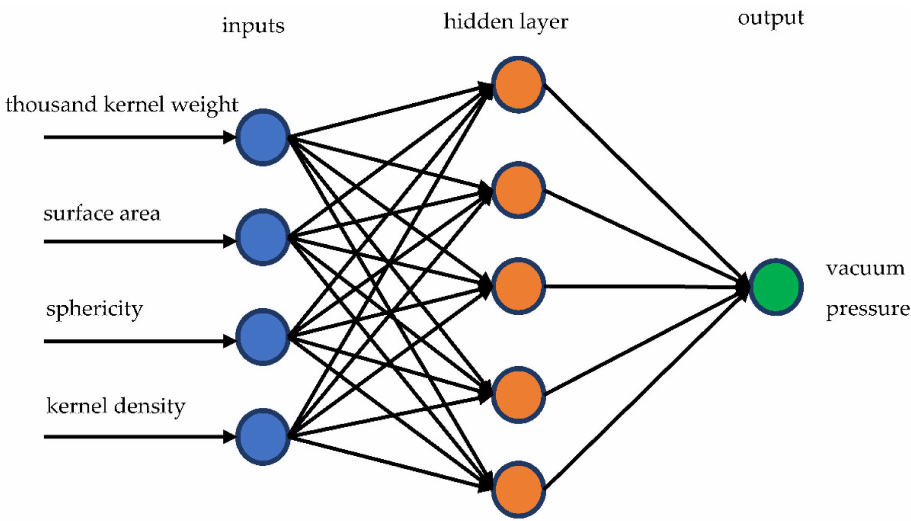
Figure 2. ANN representation used in vacuum pressure